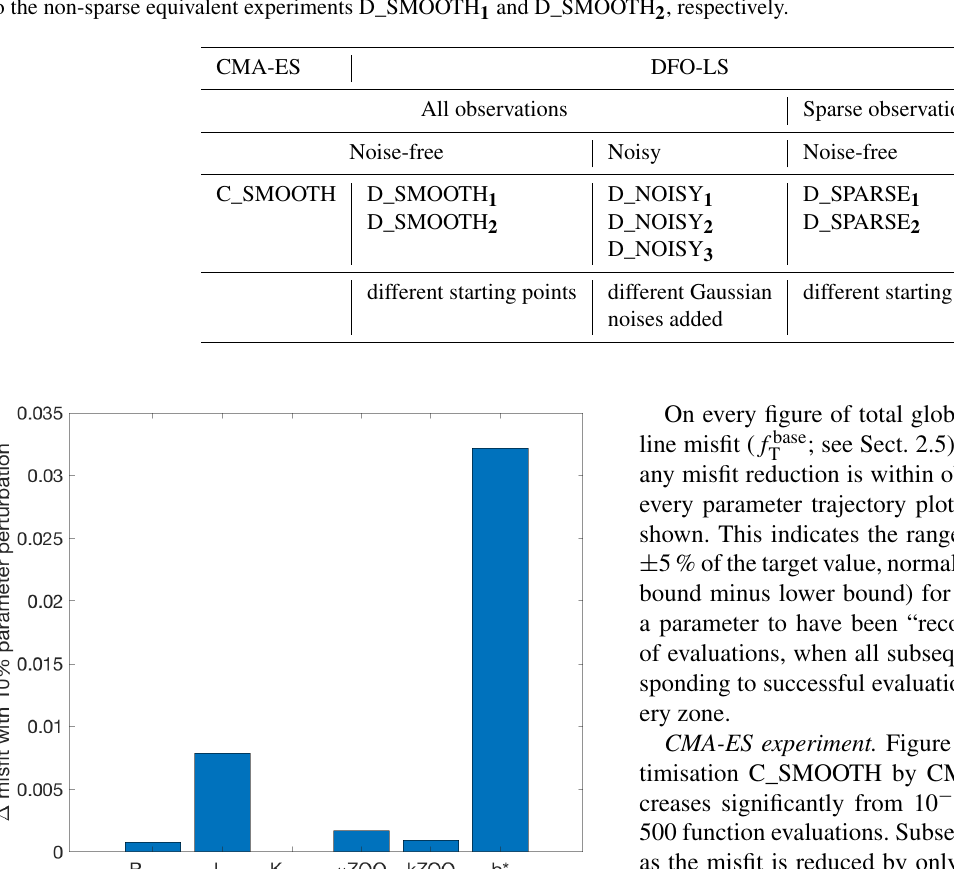
Table 1. Names of each experiment tuning to noise-free, noisy and sparse twin observations. C_SMOOTH is the non-noisy CMA-ES experi- ment. D_SMOOTH 1 and D_SMOOTH 2 are the non-noisy DFO-LS experiments starting from two different locations in parameter space, run specifically to be compared to C_SMOOTH. D_noise_randi are the noisy DFO-LS experiments, with three different noise realisations, run specifically to be compared to the non-noisy equivalent experiment D_SMOOTH 1 . D_SPARSE 1 and D_SPARSE 2 are the non-noisy DFO- LS experiments calibrating to sparse observations, starting from two different locations in parameter space, run specifically to be compared to the non-sparse equivalent experiments D_SMOOTH 1 and D_SMOOTH 2 , respectively.